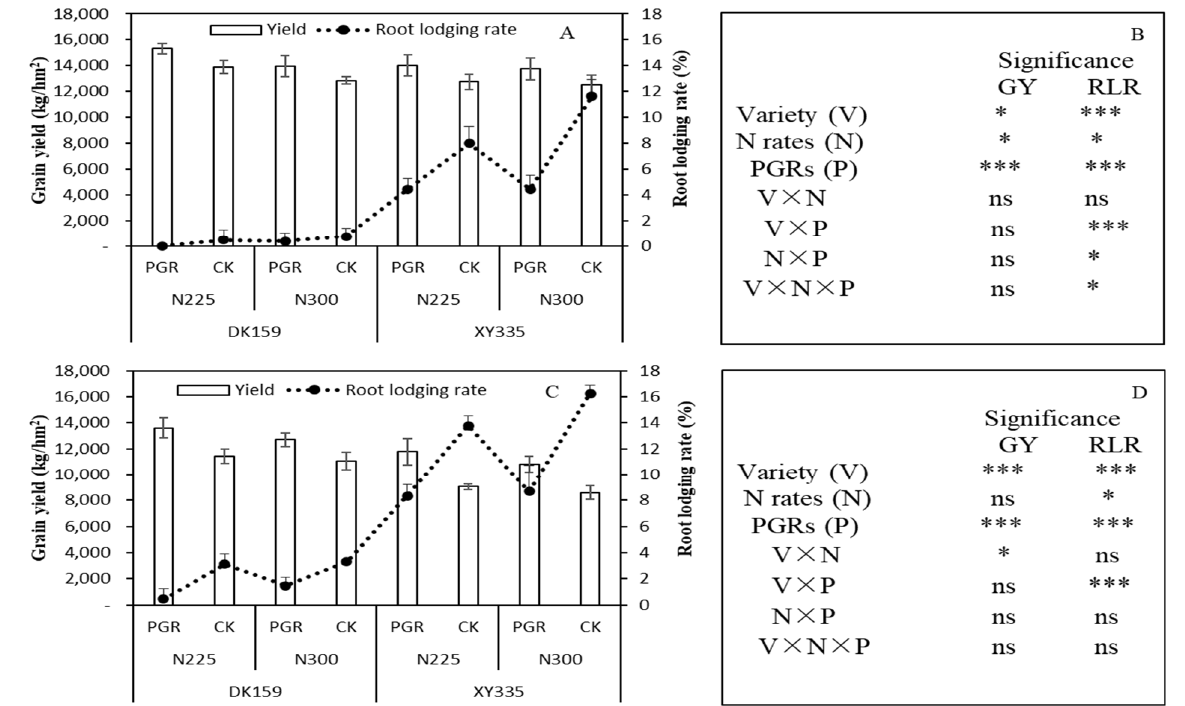
Figure 4. Effects of PGRs on grain yield and root lodging rate in 2019 ( A ) and 2020 ( C ). Effects of Variety (V), N rates (N), PGRs (P), and their interaction effects in 2019 ( B ) and 2020 ( D ) were listed (GY represents grain yield; RLR represents root lodging rate). The vertical bars denote the mean ± the standard error of the mean; ns means non-significant; * and *** indicate significance at p < 0.05 and <0.001 probability levels, respectively.